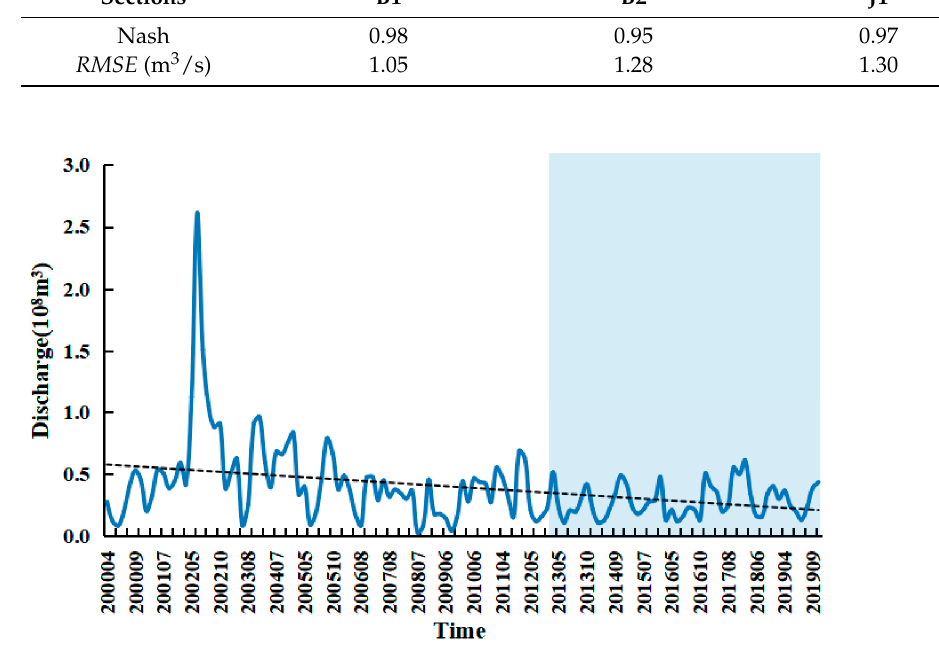
Figure 6. Variation of average annual inflow from 2000 to